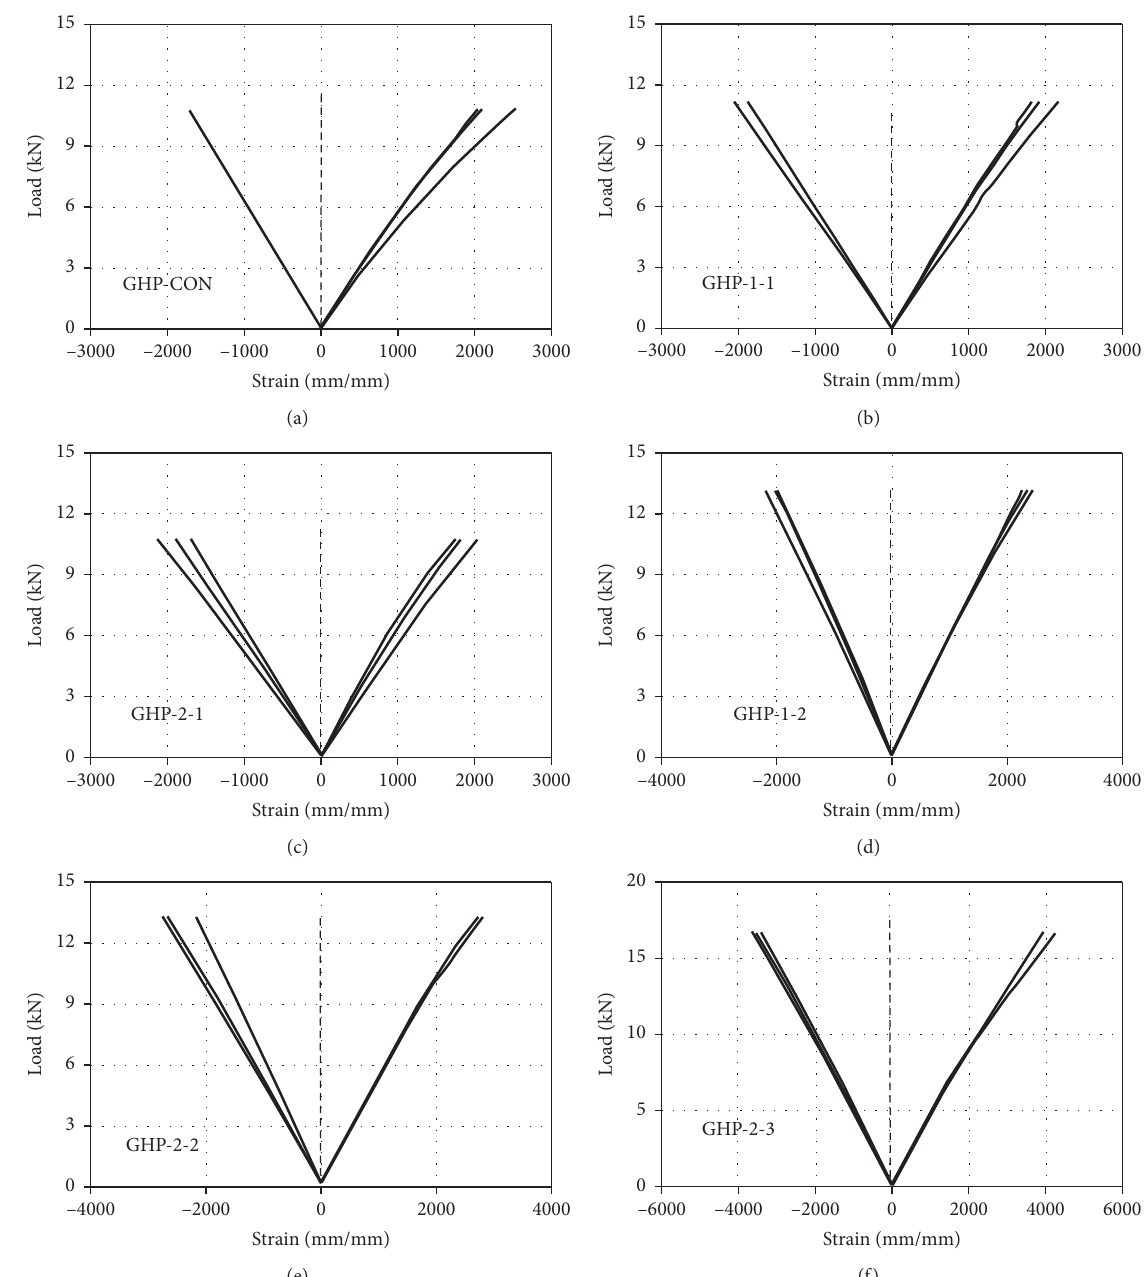
Figure 5: Midspan load-strain behavior of GHP specimens. (a) Specimen GHP-CON. (b) Specimen GHP-1-1. (c) Specimen GHP-2-1. (d) Specimen GHP-1-2. (e) Specimen GHP-2-2. (f) Specimen